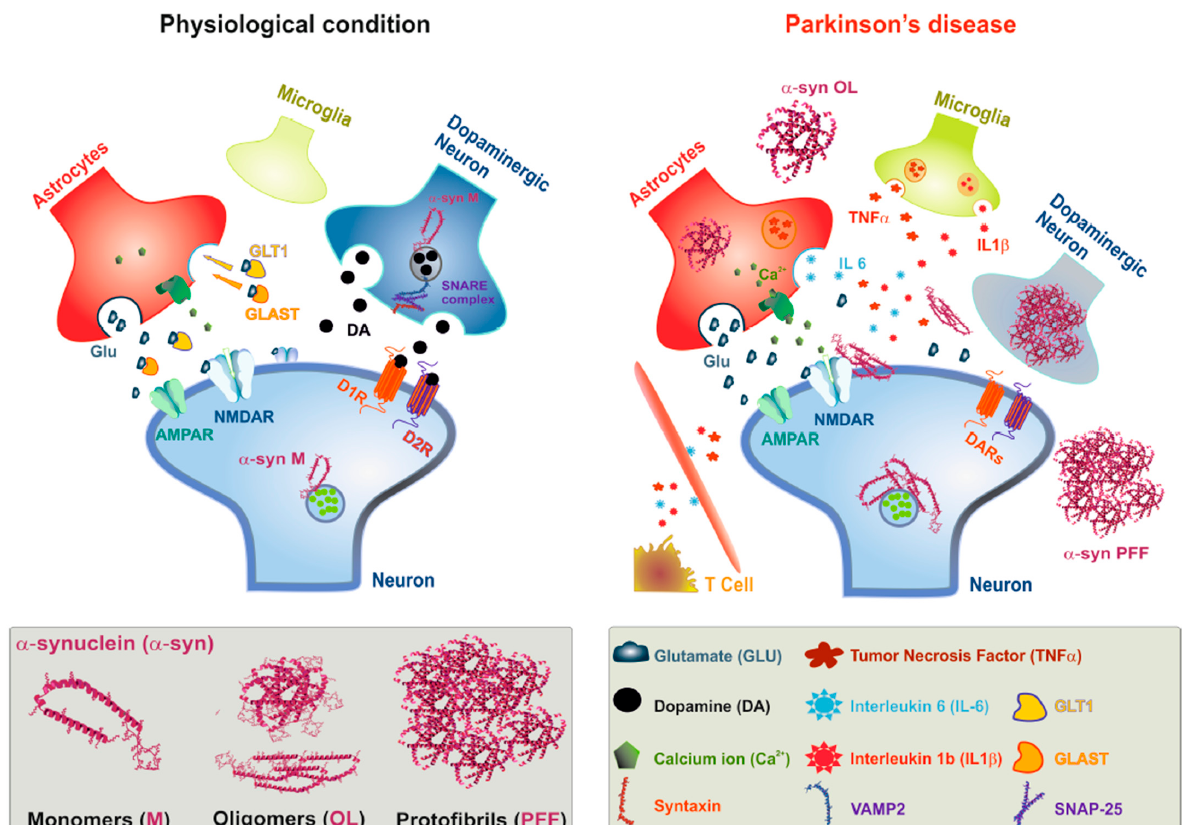
Figure 1. The presynaptic exo-endocytotic cycle is specifically affected in α -syn-related synaptopaties. α -syn accumulation in the presynaptic terminals causes synaptopathy, ultimately leading to neurodegeneration. Under physiological conditions, α -syn, as a monomer, acts at the presynaptic terminals and activates a molecular machinery relevant to synaptic transmission, including the SNARE complex proteins, which recruit synaptic vesicles. After docking and priming, the vesicles undergo SNARE-mediated membrane fusion at the active zone, leading to neurotransmitter release into the synaptic cleft. Formation of toxic α -syn species in Parkinson’s disease (PD), such as oligomers and fibrils, has been shown to play a pivotal role in PD pathogenesis. These toxic species, which accumulate at the presynaptic terminal, lead to altered levels of proteins involved in synaptic transmission, determining synaptic dysfunction. Toxic α -syn accumulation affects the synapses, causing a lack of long-term synaptic plasticity expression, followed by an increase in the phosphorylation of glutamate receptors and a decrease in the GluN2A/GluN2B receptor subunit ratio, contributing to neuronal degeneration. Toxic aggregated α -syn forms participate in inflammatory processes mediated by microglia and astrocytes, which lose their normal physiological functions. Microglia become activated (M1) and trigger an immune response through increased receptor expression (MHCI), secretion of pro-inflammatory cytokines and chemokines, and inducing an astrocyte reaction (A1 type). Reactive astrocytes decrease glutamate uptake and release pro-inflammatory mediators. Finally, peripheral immune cells (T cells and monocytes) raid brain tissue and amplify neuroinflammation, contributing to